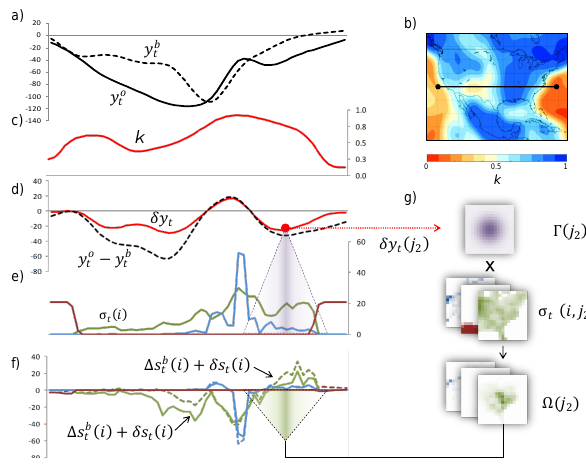
Figure 1. Illustration of the data assimilation approach followed us- ing data along a transect through the USA for August 2003. Shown are (a) monthly satellite-derived TWS, y 0 t , and the equivalent prior estimate, y b t ; (b) location of the west–east transect on a map of the gain matrix, k ; (c) profile of k along the transect (cf. Fig. 2c); (d) cal- culation of the TWS analysis increment, δ y , from k and the innova- t tion, ( y 0 t − y b t ); (e) the prior error in the change of each of the stores, σ t ( i ); (f) the prior and posterior estimate of change in each store, 1s b t (i) and 1s b t (i) + δs t (i) , respectively; and (g) visual illustration of the disaggregation of the TWS analysis increments to the differ- ent stores. All units are in millimetres unless indicated otherwise; see text for full explanation of symbols. Stores shown include the subsurface (green), rivers (blue) and sea (dark red; remaining stores not shown for